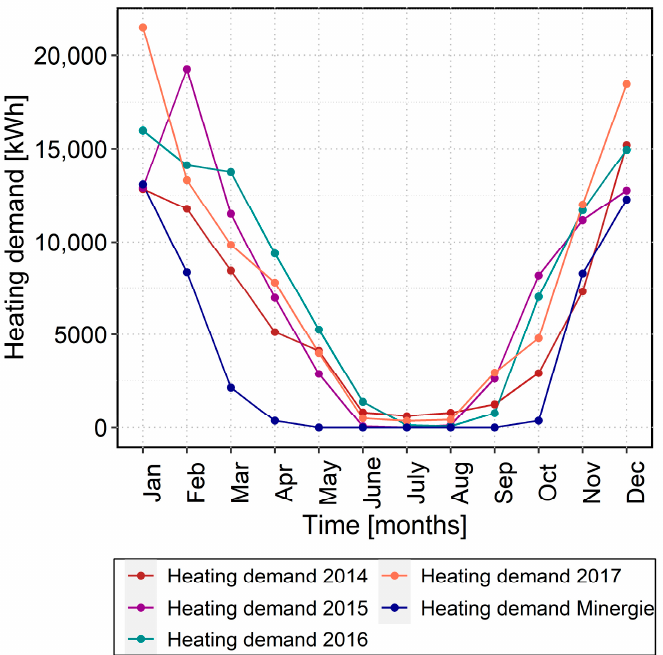
Figure 3. Normative calculated heating demand (SIA 380/1 and Minergie ® ) and measured heating demand of the building for the first four years of operational energy use.